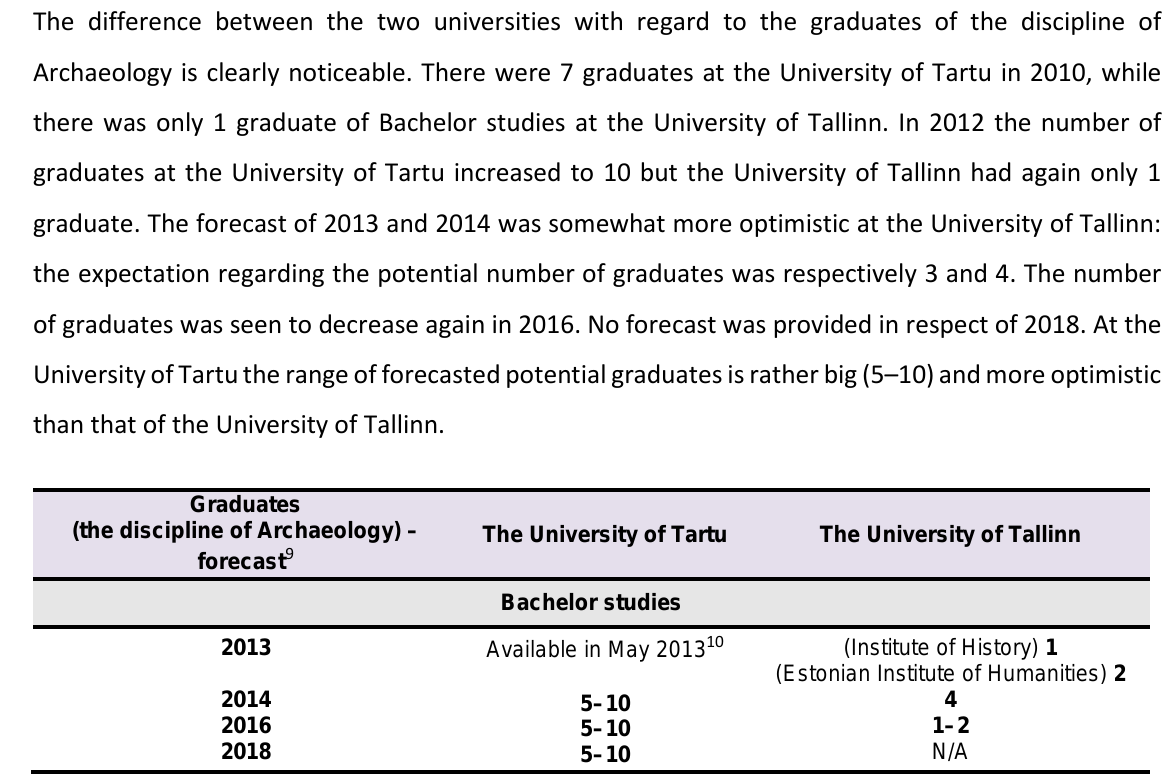
Table 10 - The graduates of Bachelor studies –